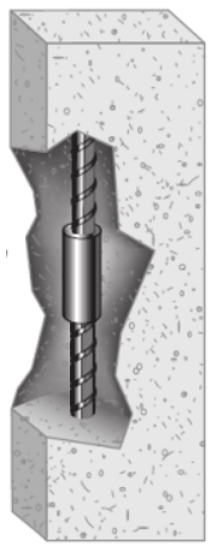
Figure 1 Illustration of a mechanical coupler splice applied at the point of union of a steel